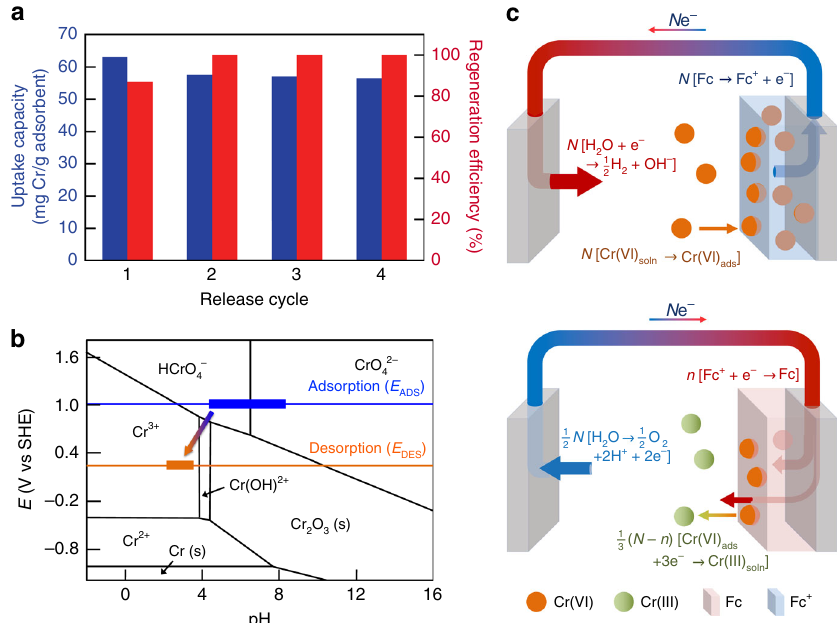
Fig. 2 Investigation of the reversibility of the electrochemically mediated capture-and-release process. a Recyclability of the electrode over a number of discharge cycles ( + 0.8 V adsorption, 0 V discharge), as given by the normalized mass released (in blue), and the regeneration ef fi ciency (%) (in red), the latter denoting the relative amount of Cr recovered relative to that adsorbed in each cycle. b The E -pH diagram for chromium speciation predominance, constructed with commercial thermochemical software (FactSage) at 25 °C for 1 mM total chromium concentration in the liquid phase. The adsorption and desorption potentials are noted, with the range of solution conditions marked both for adsorption (in blue) and desorption (in orange). c The Faradaic reactions occurring at the surface of the electrode pair are shown during both adsorption and release. During adsorption, hexavalent chromate is captured by the anode through selective binding, whereas during release, reduction of ferrocenium to ferrocene and of Cr(VI) to Cr(III)